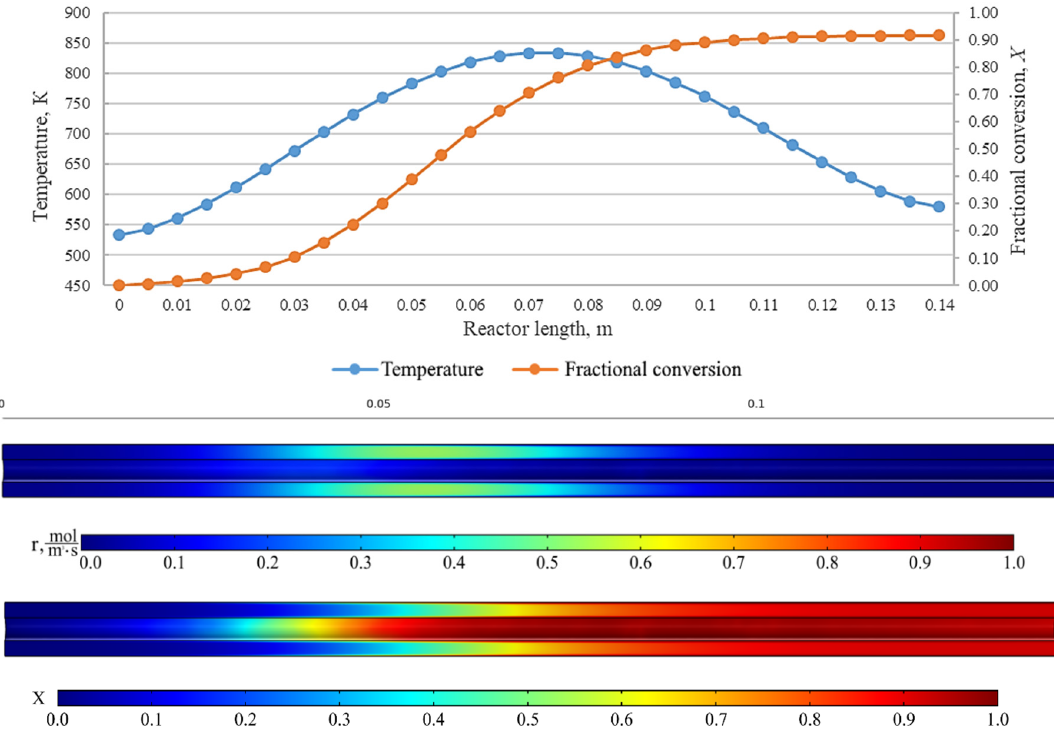
Figure 14. From top to bottom: temperature and fractional conversion curves, profiles of the reaction rate and fractional conversion along the reactor length for the experiment BuOm_550_71 (Tmax = 550 °С , 𝑉(cid:4662) = 0.05 L/min).